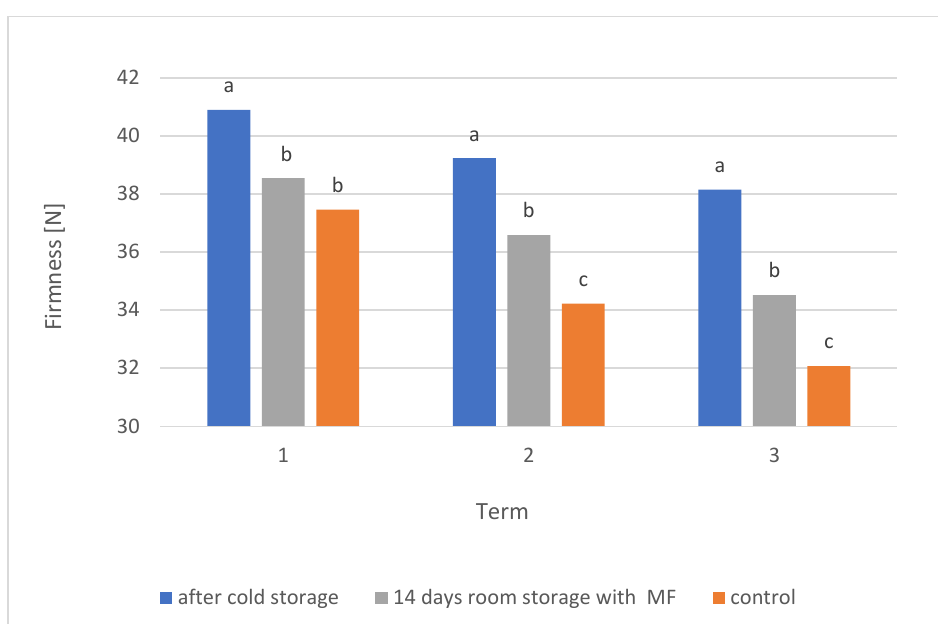
Figure 3. Effects of MF on the firmness of Idared apples after 120 days of cold storage. For each experiment, apples were stored in room conditions for 14 days. Statistically significant differences are marked by different letters. Differences between average values that are marked with the same letters (a – b) are not statistically significant. The data were analysed separately for each experiment.